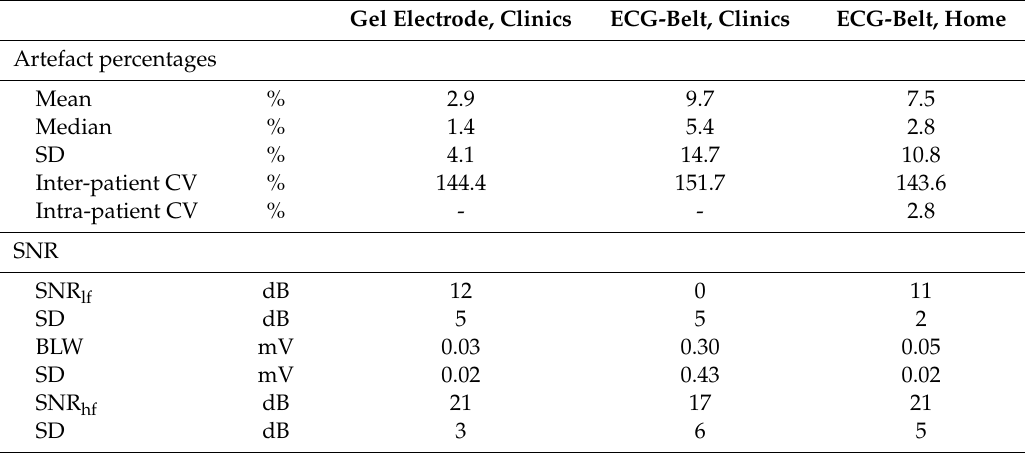
Table 2. Mean values of artefact percentages and signal-to-noise ratios (SNR) for measurements using gel electrodes and the electrocardiography (ECG)-belt in clinical (data from Fontana et al. [9]) and home settings ( n = 12).